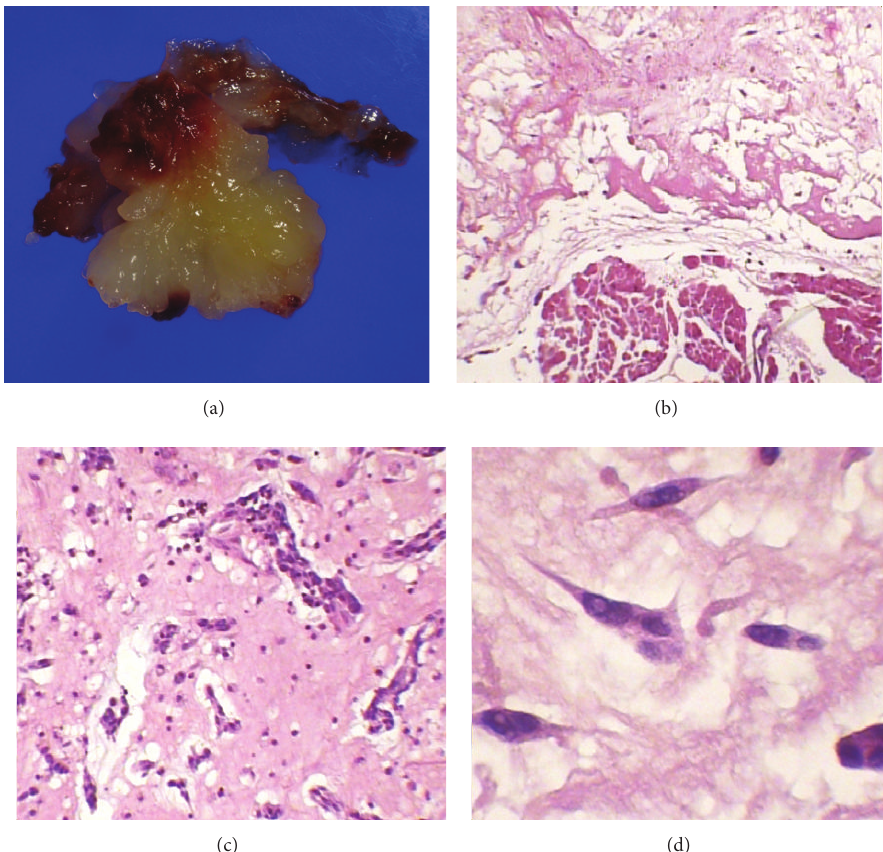
Figure 1: (a) Macroscopic image of the left auricular myxoma. (b) shows fusiform hyperchromatic cells immersed in a myxoid matrix and the cardiac muscle (H and E stain, 50x). (c) Groups of fusiform cells immersed in a myxoid matrix surrounded by abundant inflammatory cells (H and E stain, 100x). (d) Fusiform cells under higher magnification (H and E stain,